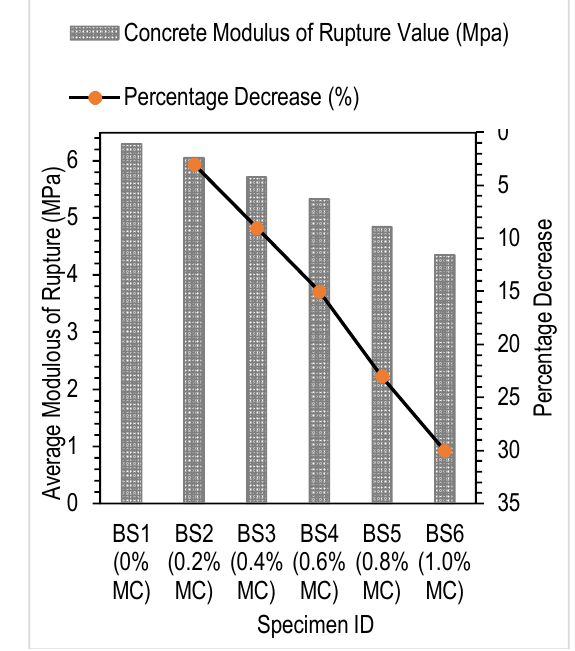
Fig. 12 Modulus of Rupture value of concrete specimens with 0%-1% MC content (1 MPa = 145.04